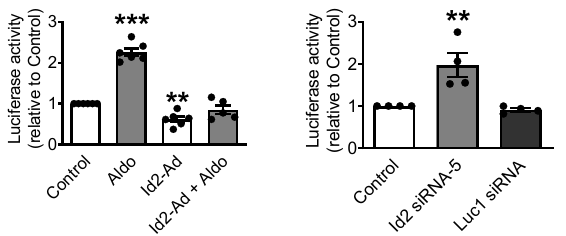
Figure 5. Id2 regulates the activity of CaV3.1 promoter. The luciferase reporter gene was placed under the control of 0.8kb of the CaV3.1 promoter. The reporter gene was transected into neonatal rat cardiomyocytes to measure the luciferase activity upon Id2 overexpression (left) or Id2 siRNA knockdown (right). Bar graphs represent the mean of the relative activity of luciferase from the CaV3.1 luciferase reporter plasmid construct. The data were evaluated by one-way analysis of variance (ANOVA) followed by Tukey–Kramer’s post hoc test. Values are mean + s.e.m., *** p < 0.001, ** p < 0.01 ( n = 4–6).